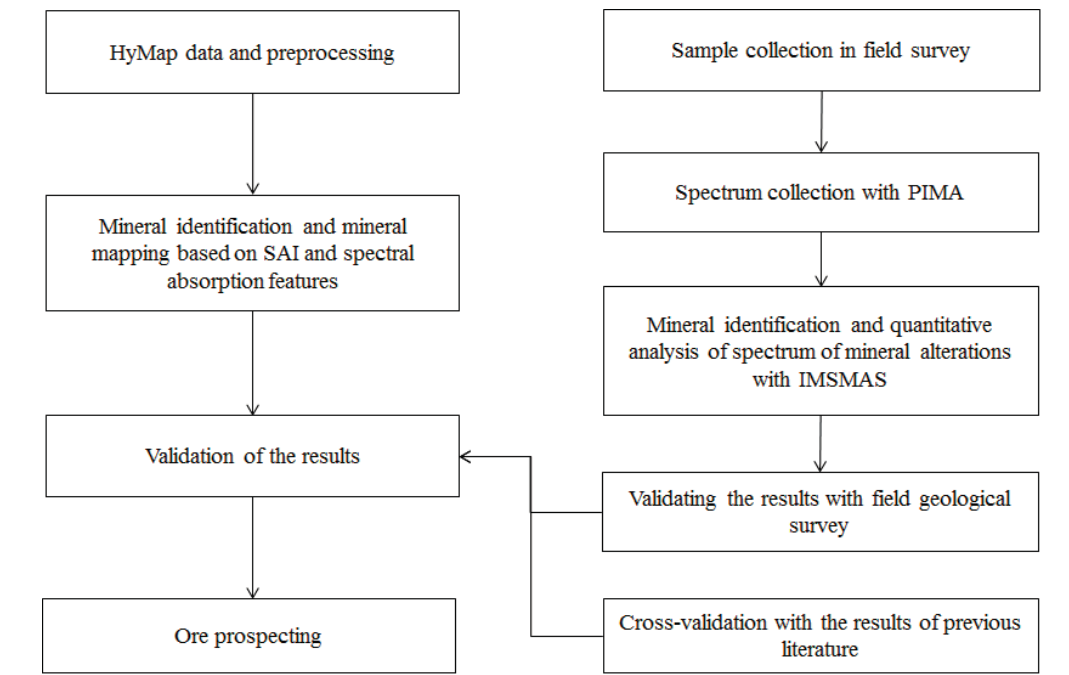
Figure 2. Flowchart of the study.